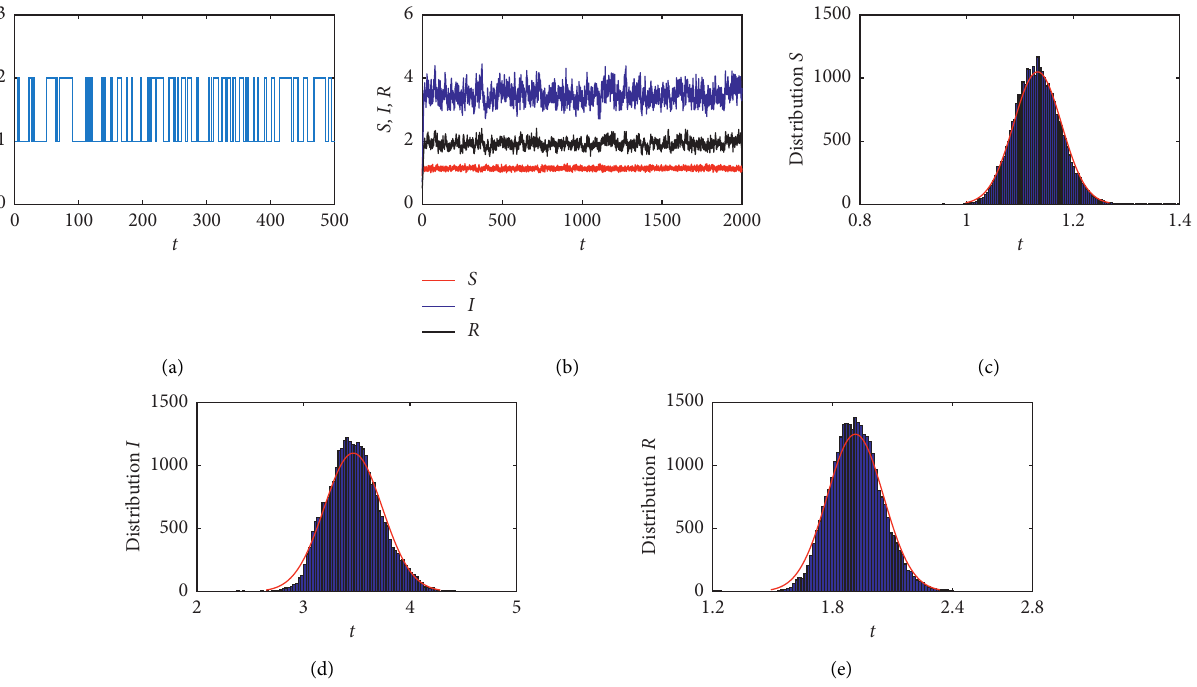
Figure 3: (a) Markov chain. (b), (c), (d), and (e) Distributions of S ( t ) ,I ( t ) , and R ( t ) of model